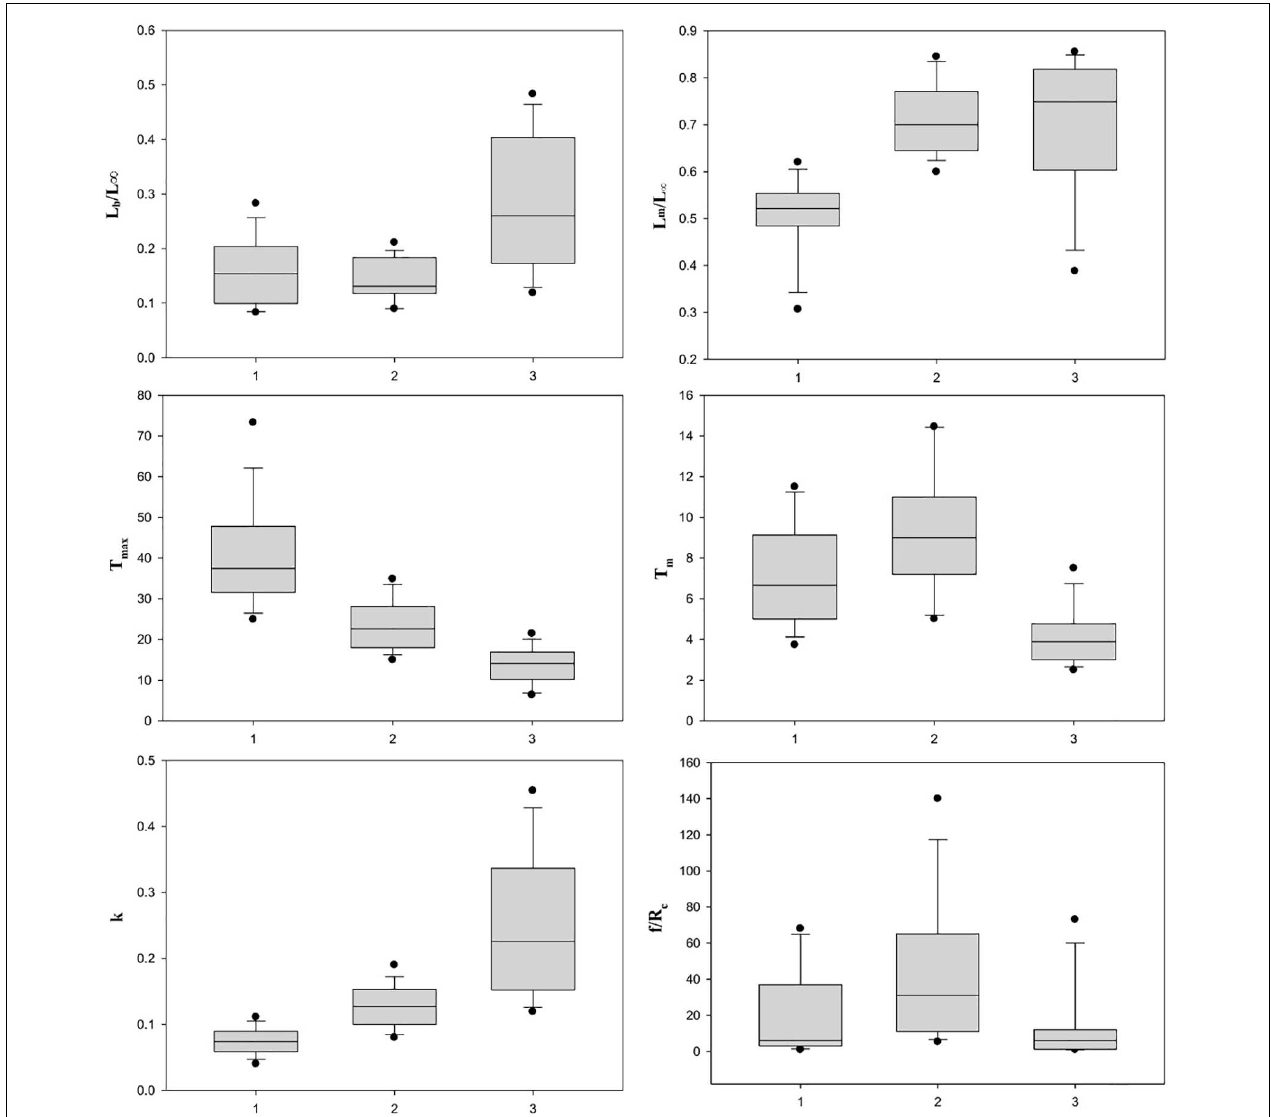
FIGURE 2 | Box plot of six life history parameters by